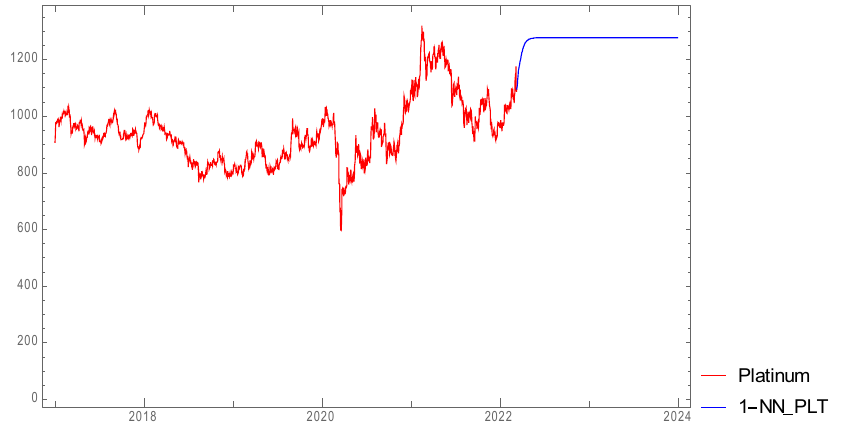
Figure 8. Past development of platinum prices from 2017 and predicted prices until the end of the year 2023.